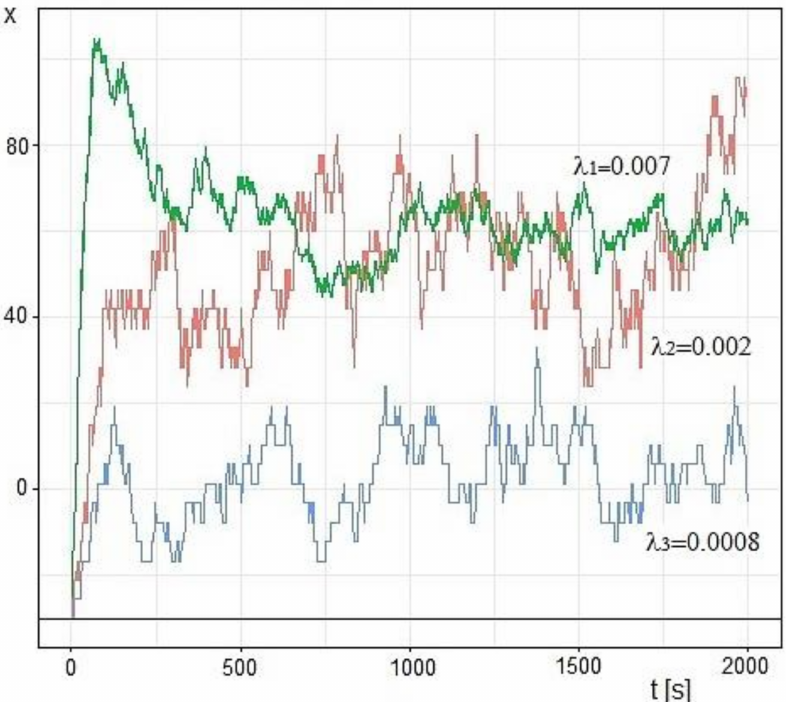
Figure 4. Simulation of gains α for the values λ 1 = 0.0008, λ 2 = 0.002, and λ 3 = 0.007 and µ = 0.009. The horizontal line crossing the OY axis in the value ( − 30) determines the fixed cost of maintaining the vehicles.